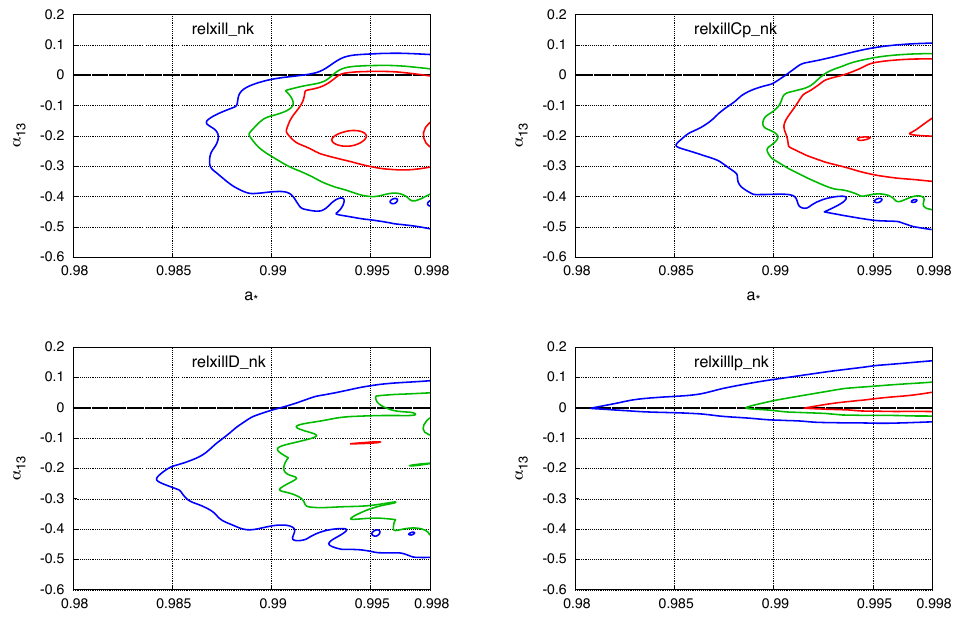
Figure A2. Constraints on the spin parameter a ∗ and the Johannsen deformation parameters α 13 for Ton S180 when the reflection component is modeled by RELXILL _ NK ( top left panel ), RELXILL C P _ NK ( top right panel ), RELXILL D_ NK ( bottom left panel ), and RELXILLLP _ NK ( bottom right panel ). The red, green, and blue curves are, respectively, the 68%, 90%, and 99% confidence level boundaries for two relevant